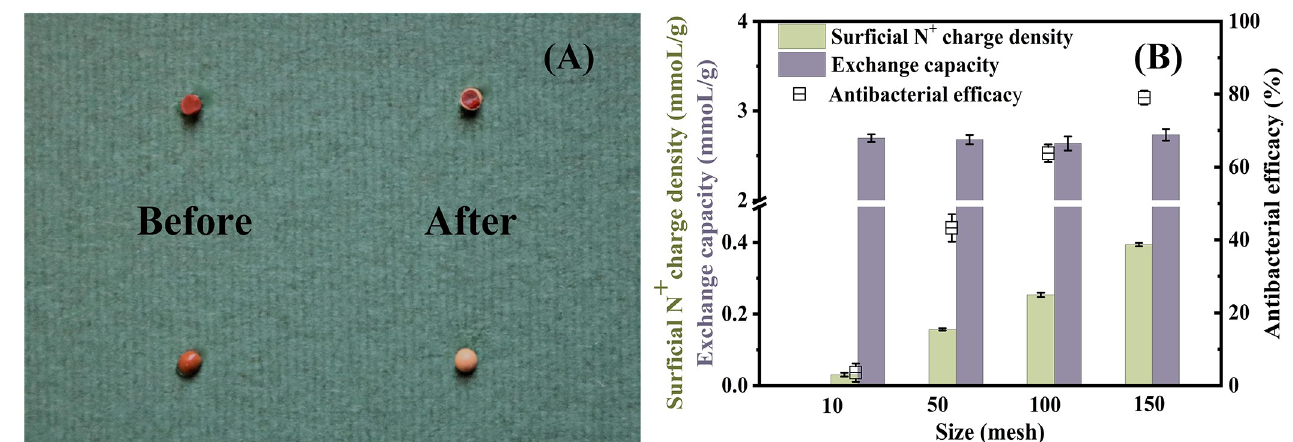
Fig 2. (A) Features of resin D213 before and after detection of surficial N + charge density; (B) changes in surficial N + charge density, exchange capacity and antibacterial efficacy with increasing resin sizes of Py-1C. One resin sphere of D213 was cut into two parts (A), one for showing its interior and the other for showing its surface. The above surficial N + charge densities were detected with the method B1 in Table 1. All antibacterial experiments were performed at least in triplicate, and the error bars indicate the standard deviations from the mean values obtained.